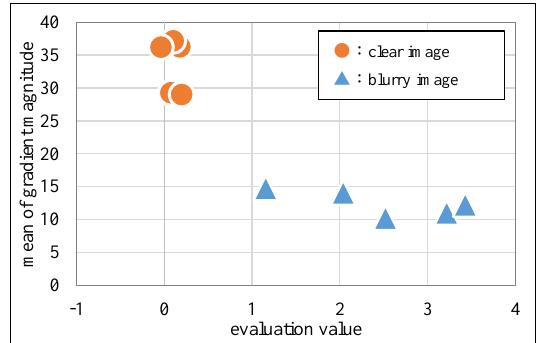
Figure 9. Evaluation value of each image